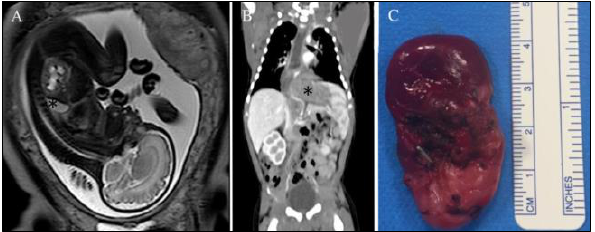
Figure 1: (A) Prenatal MRI is showing an expansive lesion located in the posterior mediastinum. (B) Postnatal computed tomography image showing the lesion located at the level of T8 vertebra (*), supplied by an arterial vessel, coming from the celiac trunk. (C) Macroscopic finding.